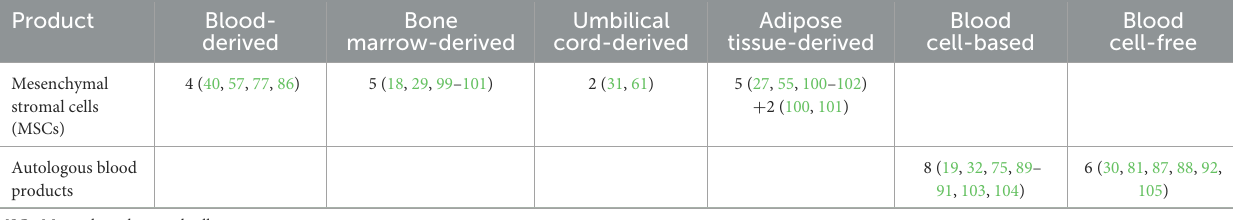
TABLE 4 Numbers of studies from qualitative synthesis demonstrating the source and composition of orthobiologic therapeutic agents.